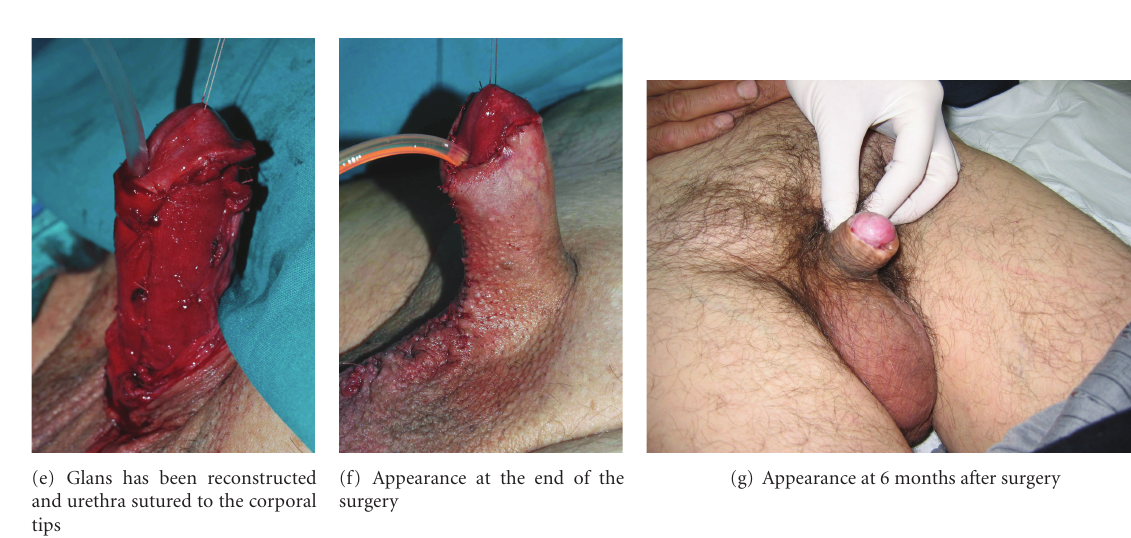
Figure 2: Penile disassembly for the conservative treatment of penile